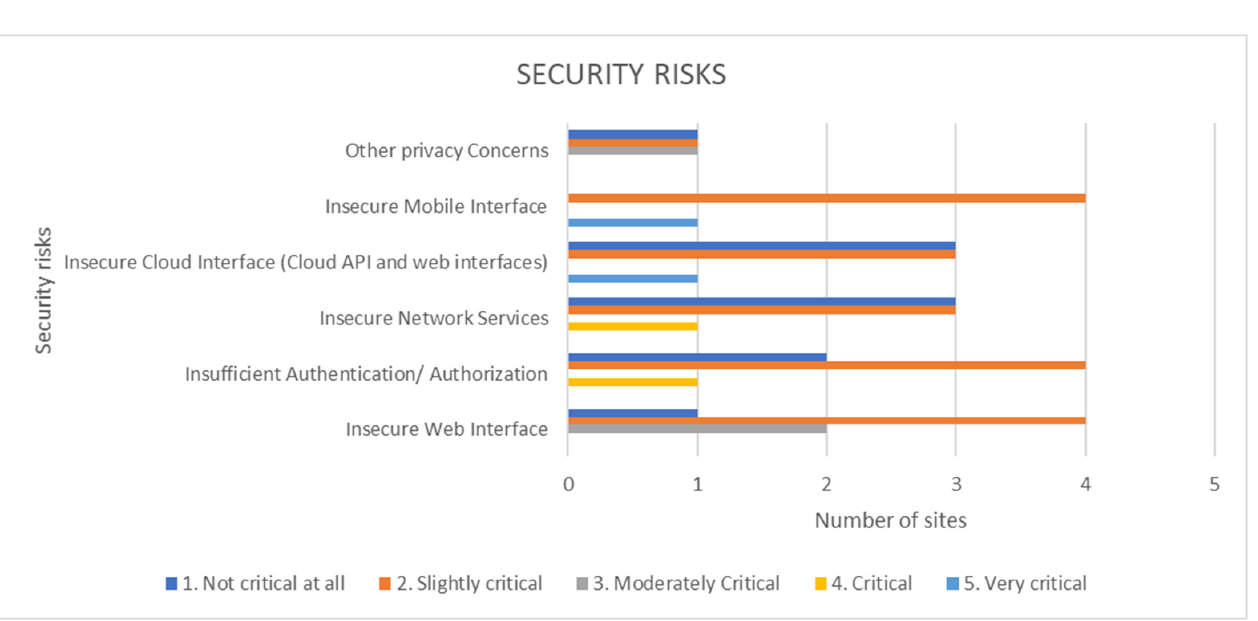
Figure 5. Data processing security risks.